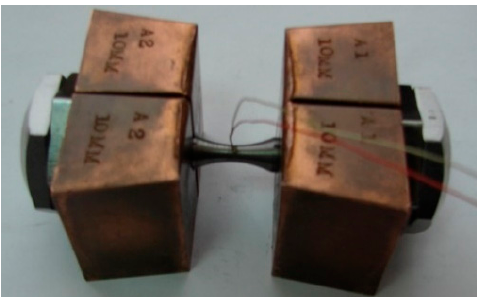
Figure 4. Clamped specimen with a connected thermocouple, prepared for mounting in the Gleeble simulator.